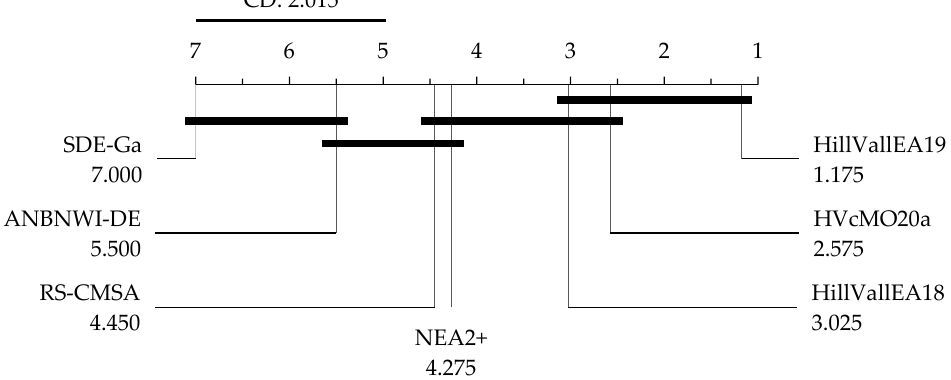
Figure 6. Nemenyi test regarding dynamic F1. Connected optimizers are not statistically different.